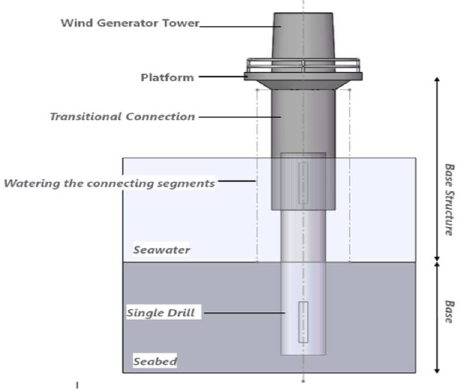
Figure 1. Wind farm grouted joint.